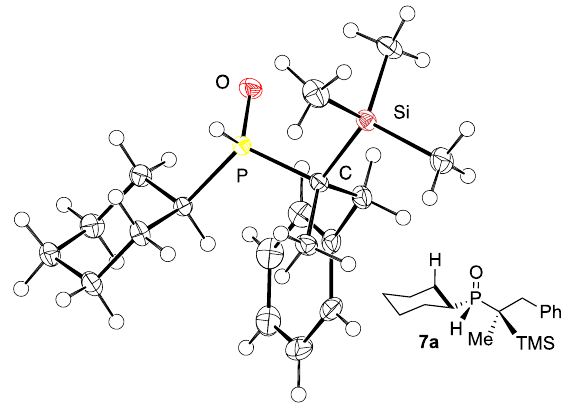
Figure 1. ORTEP drawing of S p. S c- 7a at the 50% probability level. The reaction in Table 1 should begin with the formation of phosphorus-centered rad- ical 8 [51] (Figure 2), which then adds to the alkene 6a . To elucidate the structure of 8 , molecular orbital calculations at the UHF/6-31G (d, p) level of theory [52] were carried out. The results showed two stable diastereomers: 8a and 8b , whereby the radical center at the phosphorus atom was oriented in the same or opposite direction toward the carbon- silicon bond. The diastereomer 8b was more stable than 8a by about 0.5 kcal/mol. The